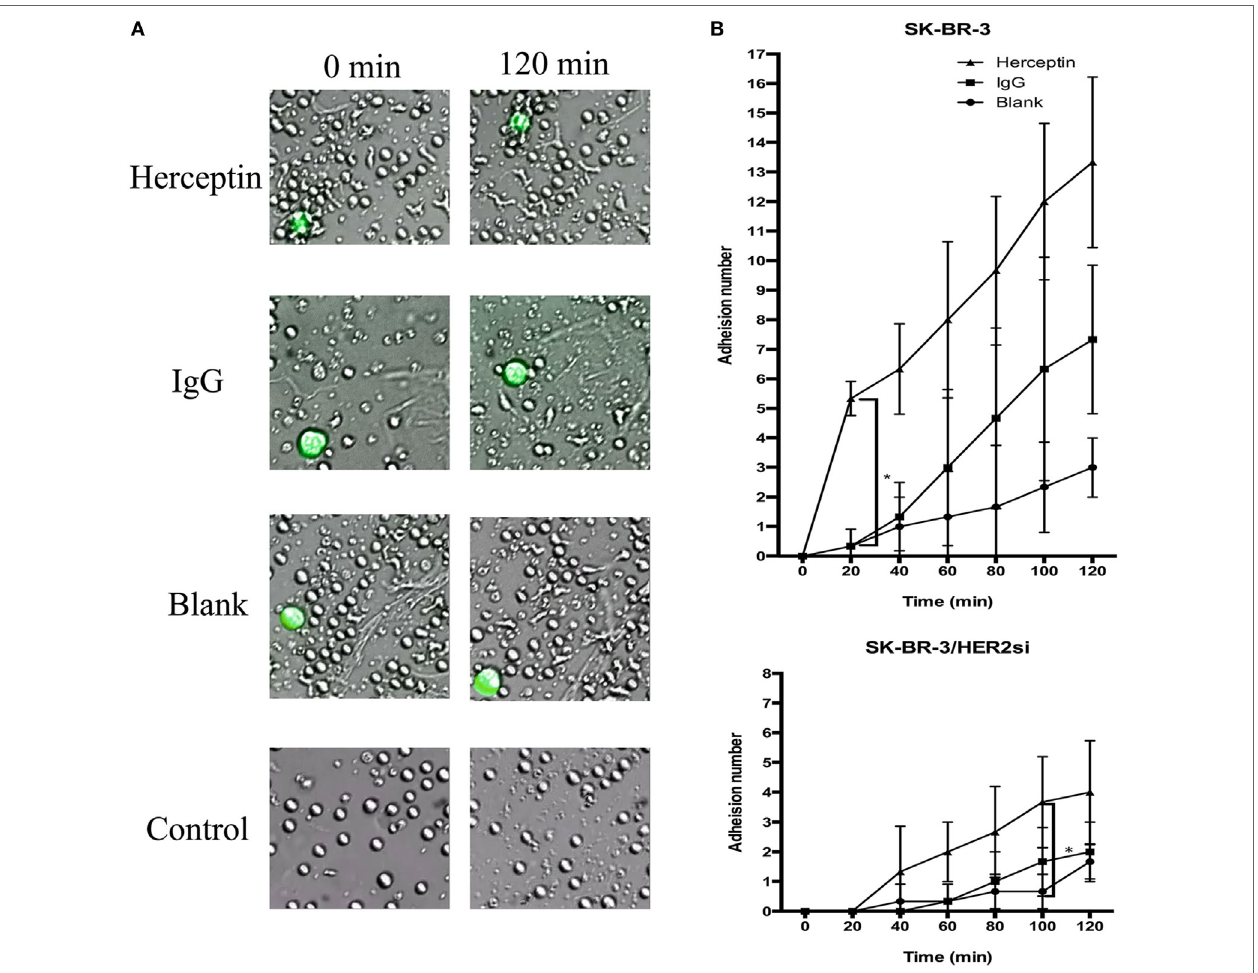
FigUre 3 | The migration and adhesion of expanded natural killer (NK) cells. The larger green cells in the photos are target cells and the smaller cells are NK cells. (a) Images of expanded NK cells cocultured with SK-BR-3 at 0 min (left row) and 120 min (right row). (B) Statistical analysis of the calculated number of adherent NK cells. The results are presented the means of three independent experiments and error bars represent the SD. * p <